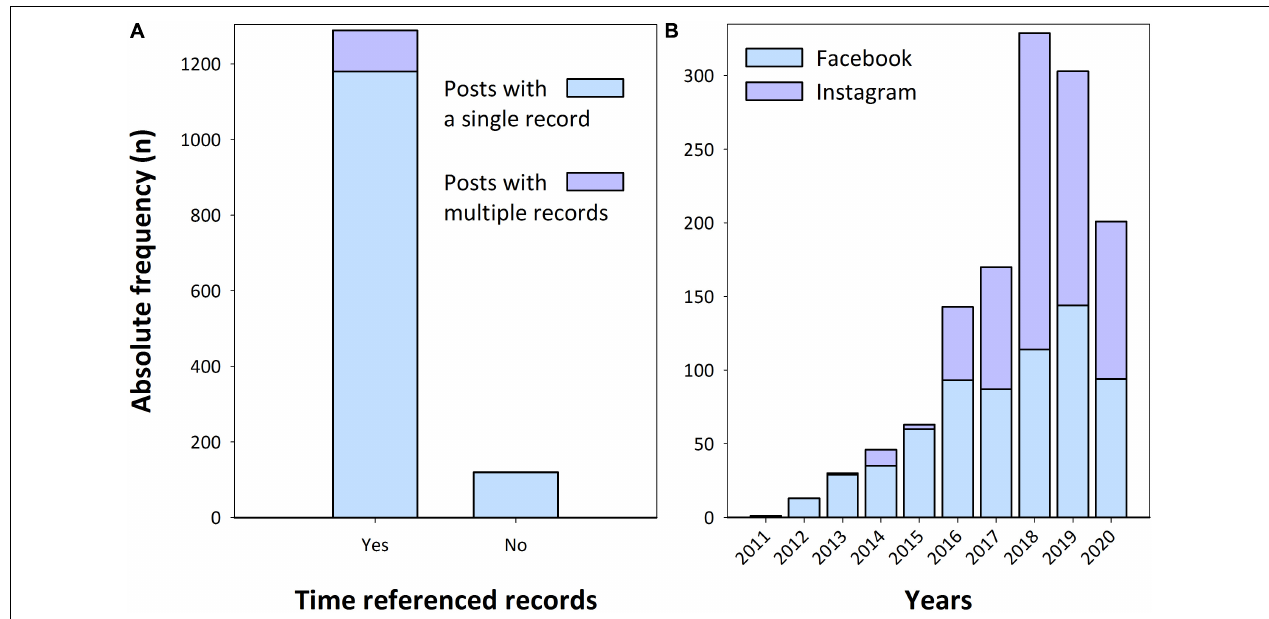
FIGURE 2 | Number of time-referenced vs. non-time-referenced social media posts on Facebook and Instagram made in the accounts of whale-watching companies from the Algarve (Portugal) between 2011 and 2020, and taking in consideration if a single record or multiple records were made in each post (A) , and evolution of time-referenced posts along time (B)